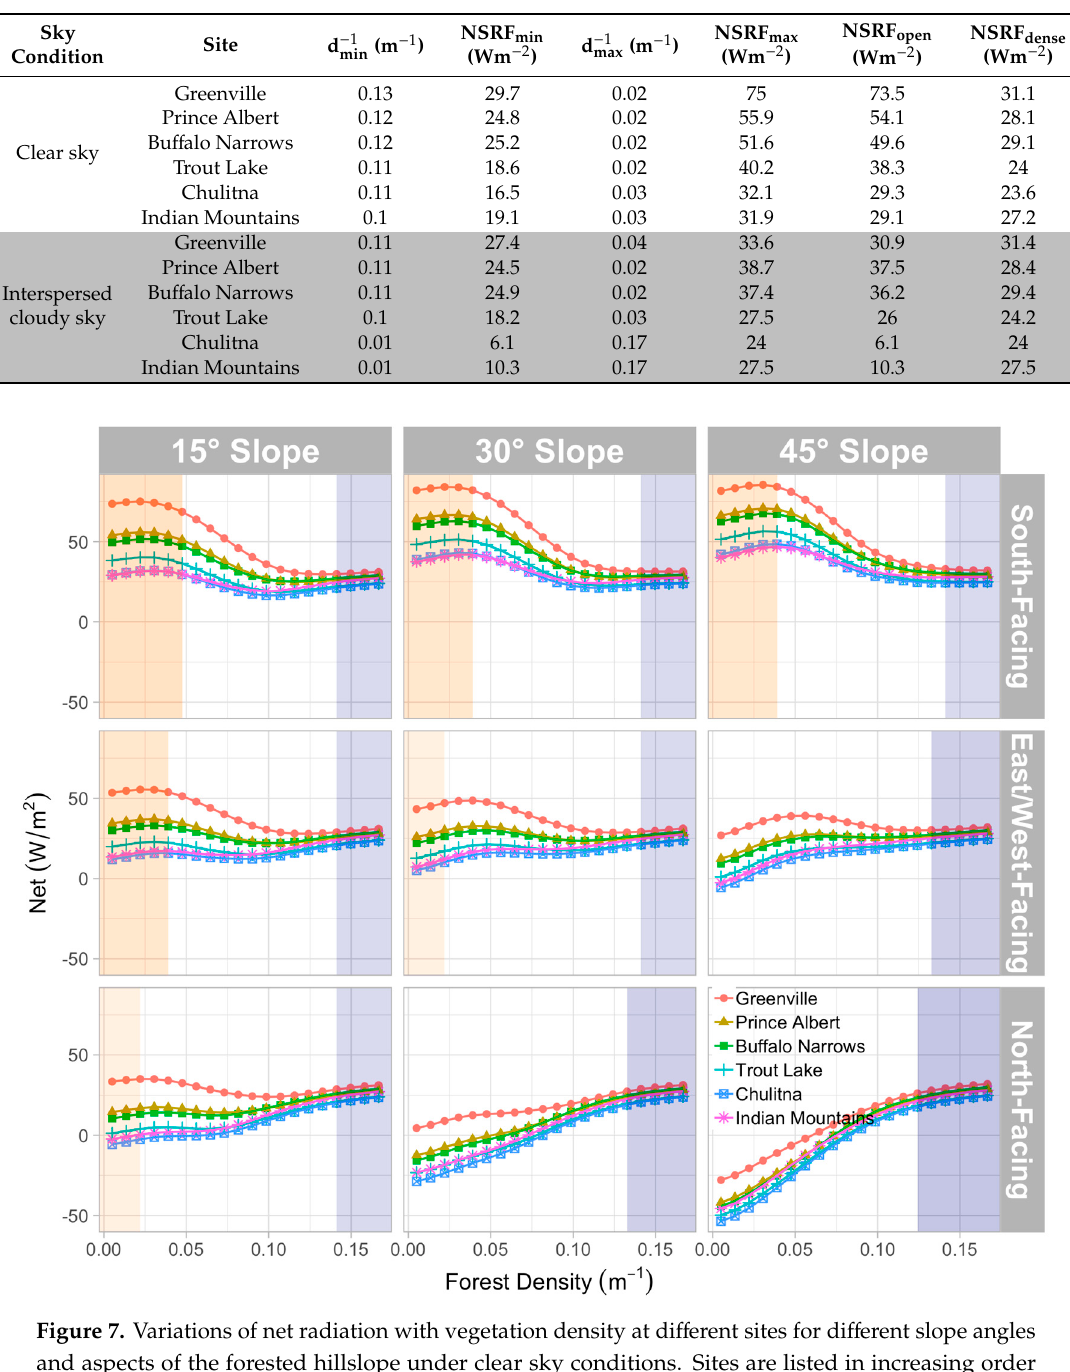
Table 4. Minimum and maximum net radiation compared to radiation in open (NSRF open ) and very dense (NSRF dense ) areas for south-facing forests with slope = 15 ◦ at di ff erent locations.